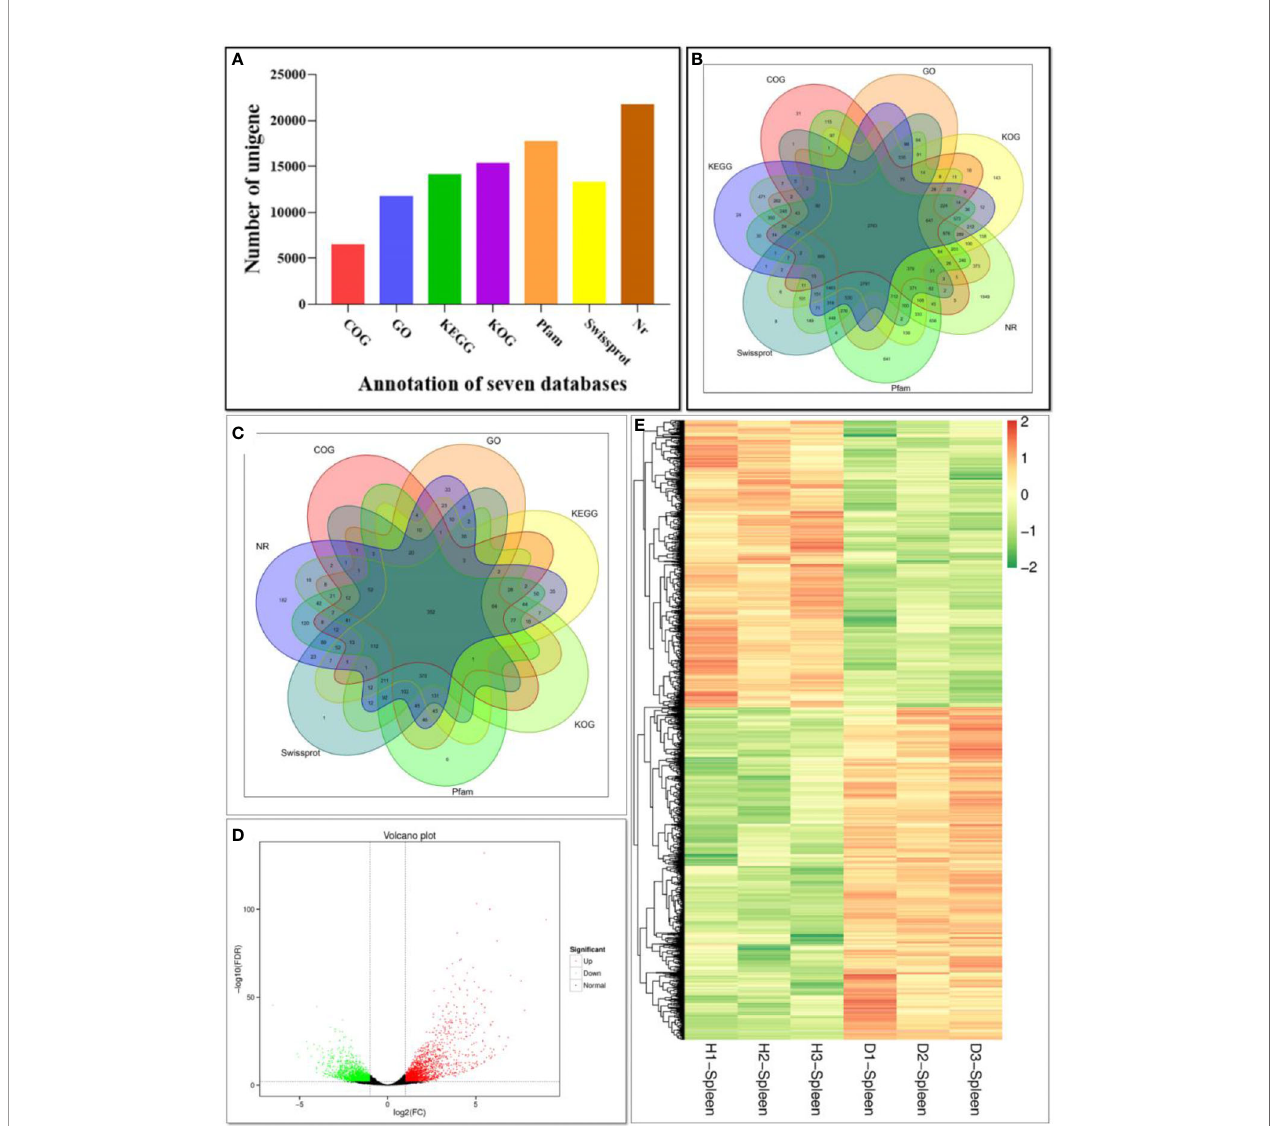
FIGURE 4 | Function annotation of unigenes based on BLAST against seven databases. (A) Numbers of unigenes annotated in seven databases. The X-axis represents different databases. The Y-axis corresponds to the number of unigenes.; (B) Venn diagram of unigenes annotated in seven databases; (C) Venn diagram of DEGs annotated in seven databases; (D) Volcano plot of DEGs comparing the diseased fi sh and healthy fi sh. The X-axis represents fold change between diseased and healthy groups. The Y-axis indicates the statistical signi fi cance of the difference of gene expression. Each dot in the diagram represents a gene, and the black dots represent no signi fi cant changes in expressed genes, while the red dots and the green dots represent up- and down- regulated in diseased fi sh, respectively. (E) Heat map of DEGs comparing the diseased fi sh and healthy fi sh. H1, H2 and H3 represent three samples of healthy individuals, and the D1, D2 and D3 represent three samples of diseased individuals. Each row represents a gene. Gene expression levels are shown with different colors. Negative and positive numbers indicate down- and up-regulation,